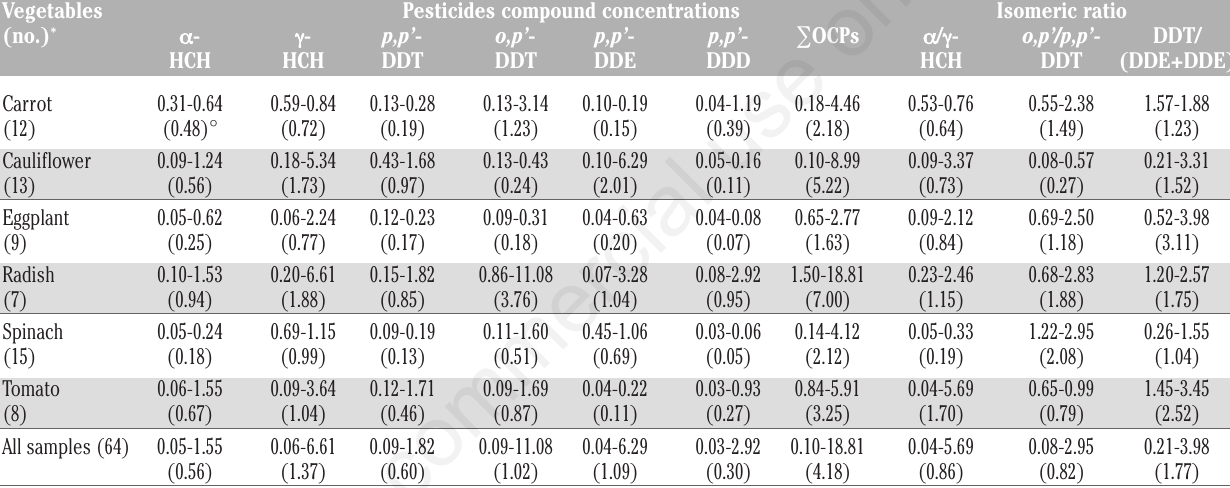
Table 1. Concentrations of hexachlorocyclohexane and dichlorodiphenyltrichloroethane pesticides in different vegetables (µg kg –1 ).